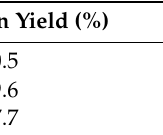
Table 2. Process Yields of PFO # -based Fibers as Functions of Thermal Treatment Conditions and Graphene addition.